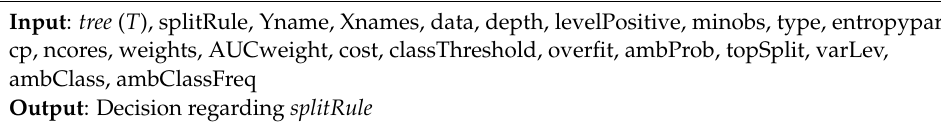
Algorithm 2: Interactive learning